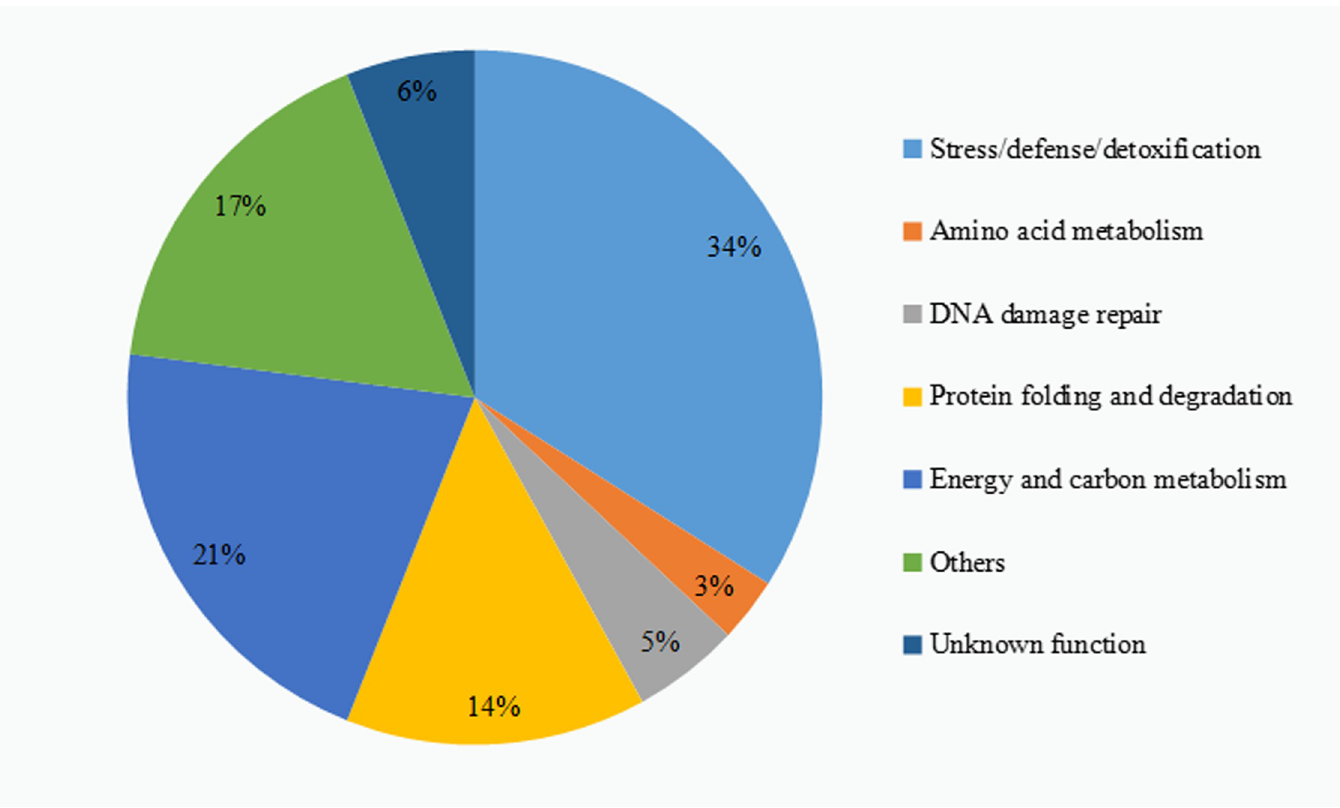
Fig 4. Differential protein function classification in group